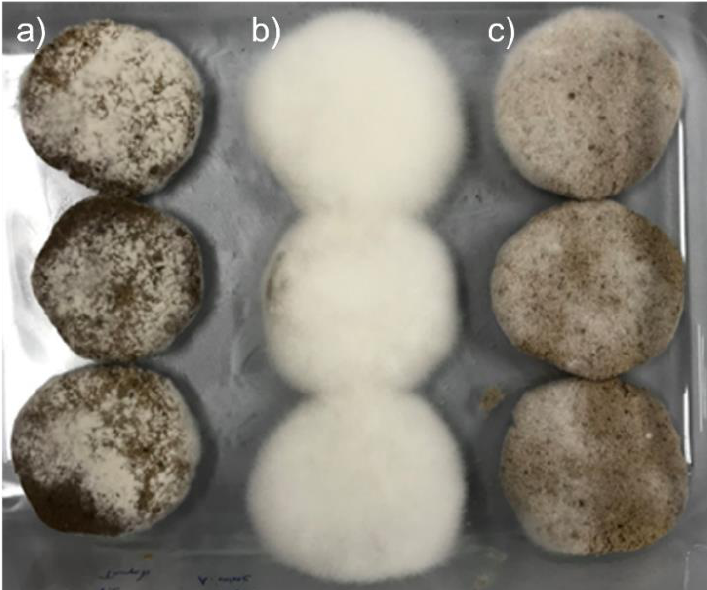
Figure 1. Growth of mold mycelia on WPC after 48 h: ( a ) A. oryzae , ( b ) R. oligosporus , and ( c ) coculture of A. oryzae and R. oligosporus .